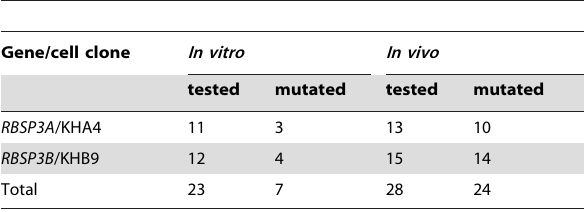
Table 4. Mutation frequency of the RBSP3A and RBSP3B genes in vitro and in vivo in the gene inactivation